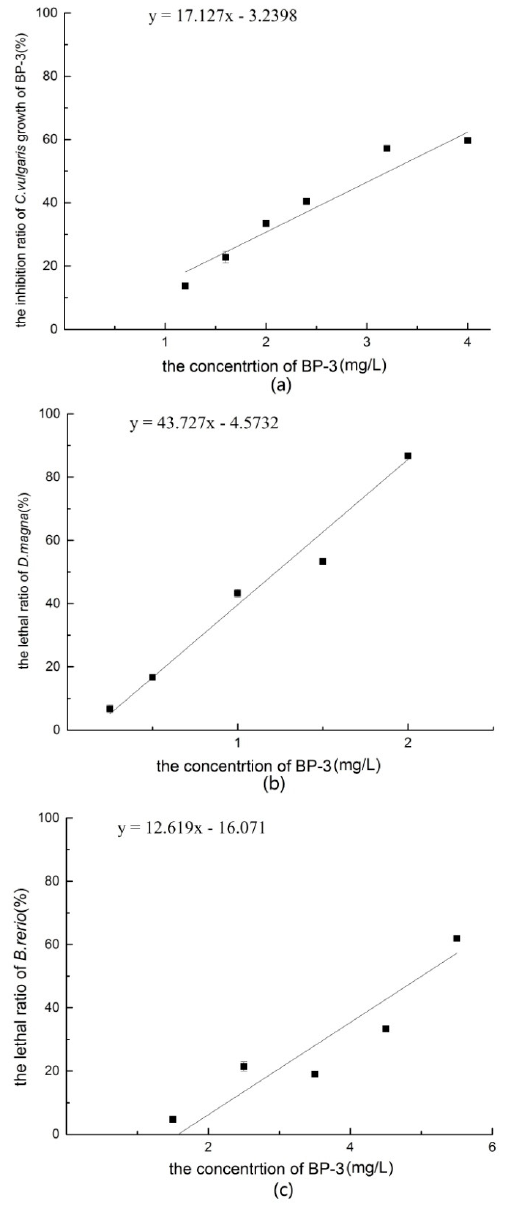
Figure 1. ( a ) The inhibition ratio of C. vulgaris growth of BP-3; ( b ) The lethal ratio of D. magna of BP-3; ( c ) The lethal ratio of B. rerio of BP ‐ 3.